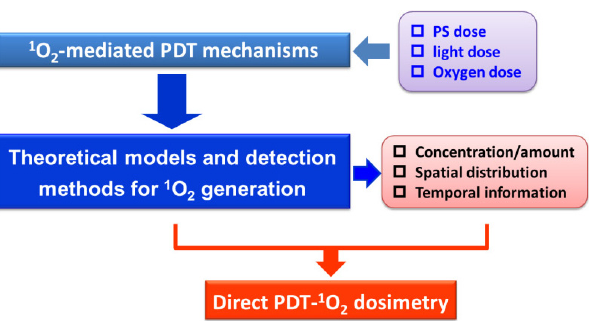
Fig. 7. Future trends in developing PDT- 1 O 2